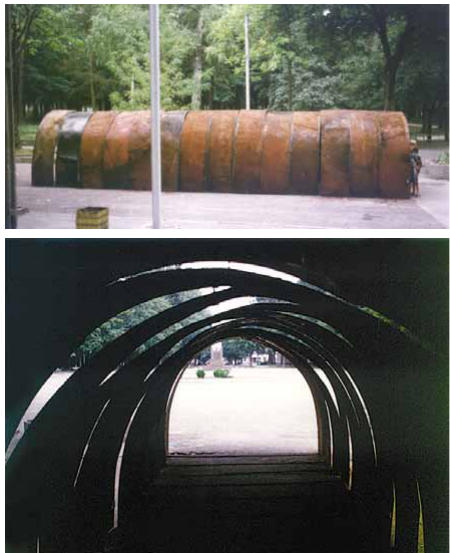
3 pav. Instaliacija „Skylė“, Alytus. K. Lupeikis + R. Nemeikšis, 1995 m. Fig. 3. Installation Hole; Alytus, Lithuania, K. Lupeikis + R. Nemeikšis,